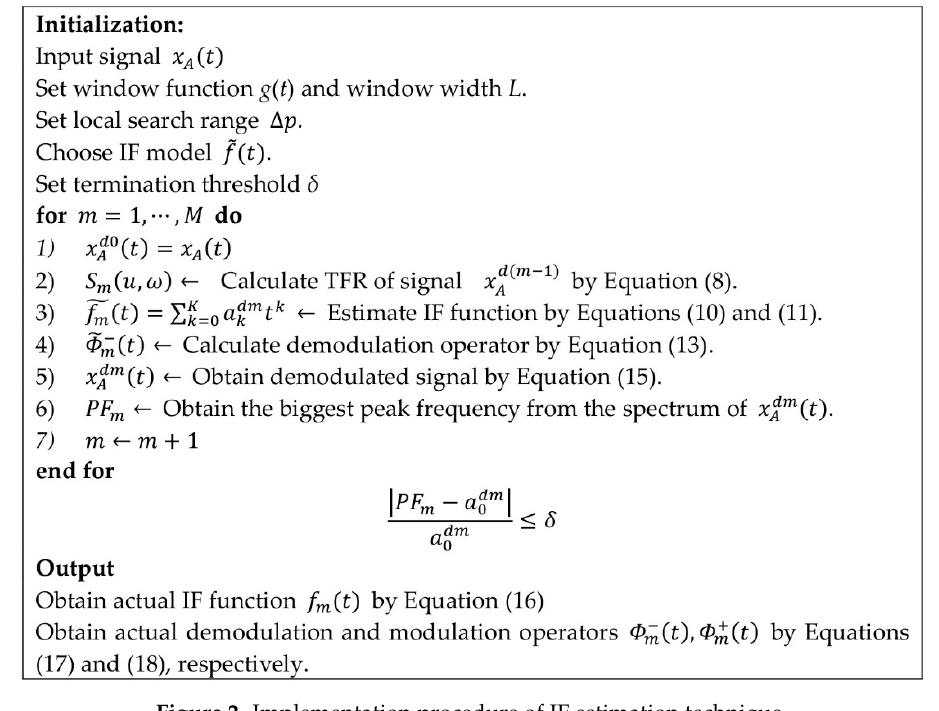
Figure 2. Implementation procedure of IF estimation technique.